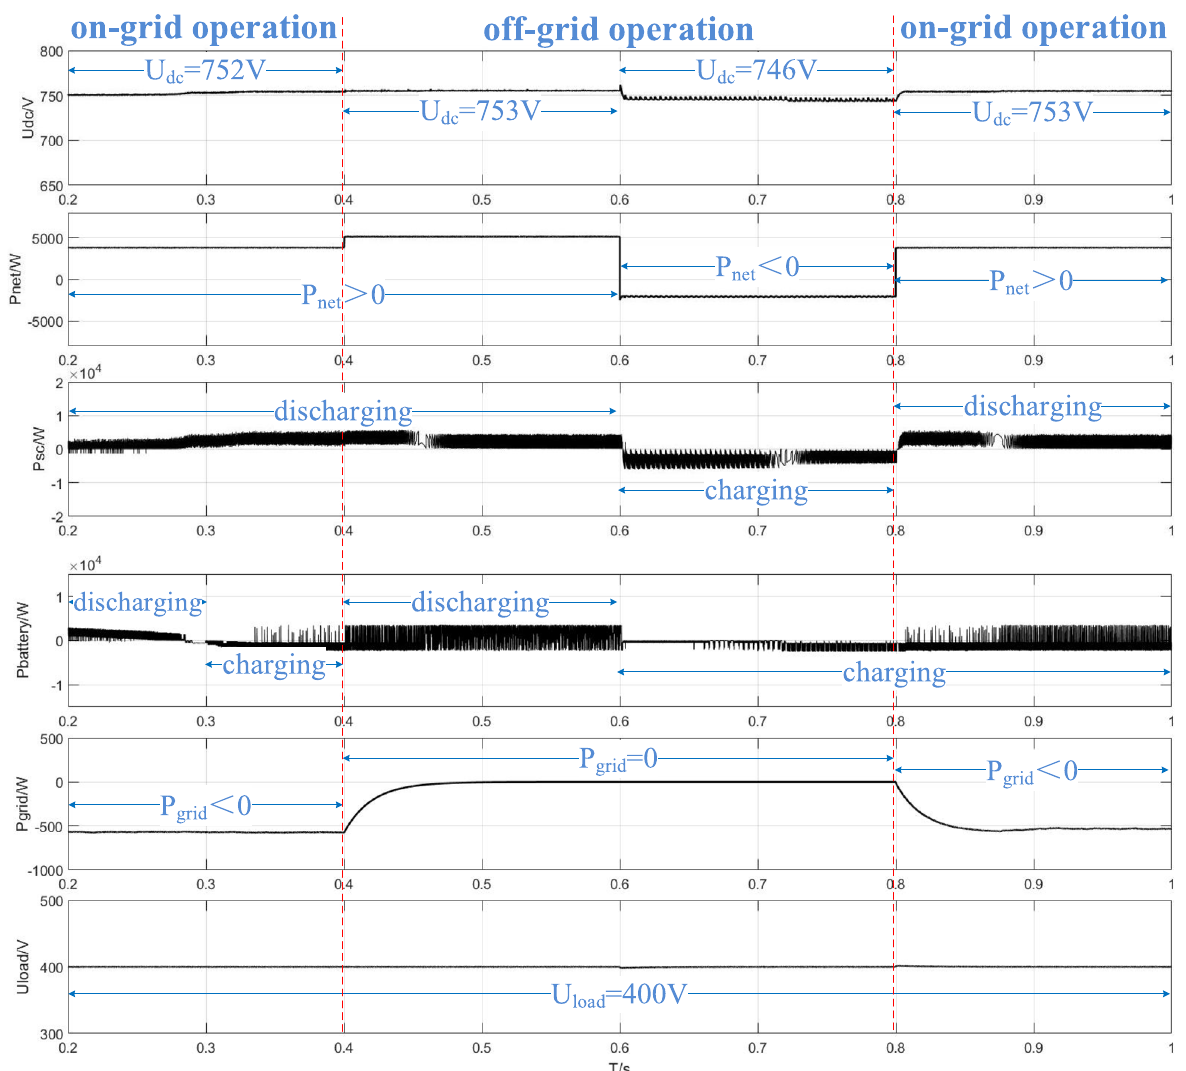
Fig. 14 Simulation results of on-grid to off-grid and then to on-grid